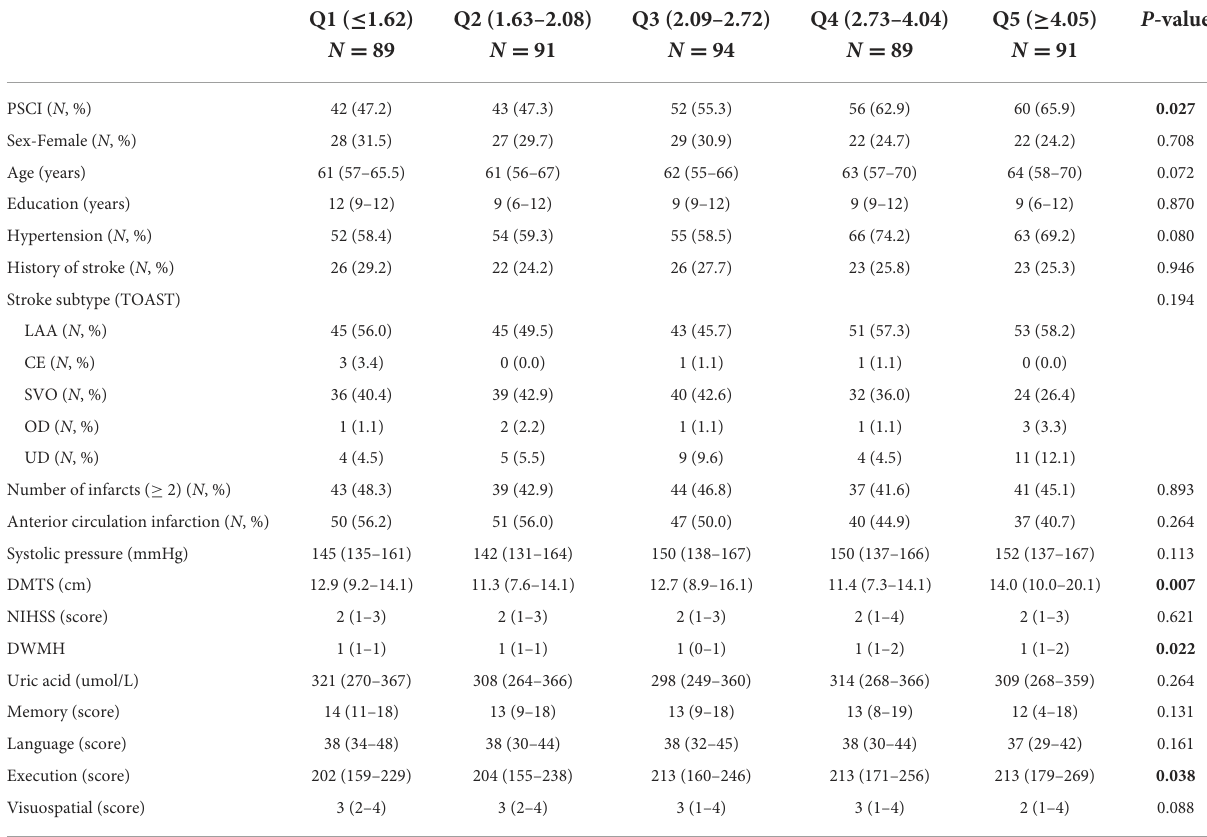
TABLE 2 Comparison of baseline characteristics between different groups in NLR